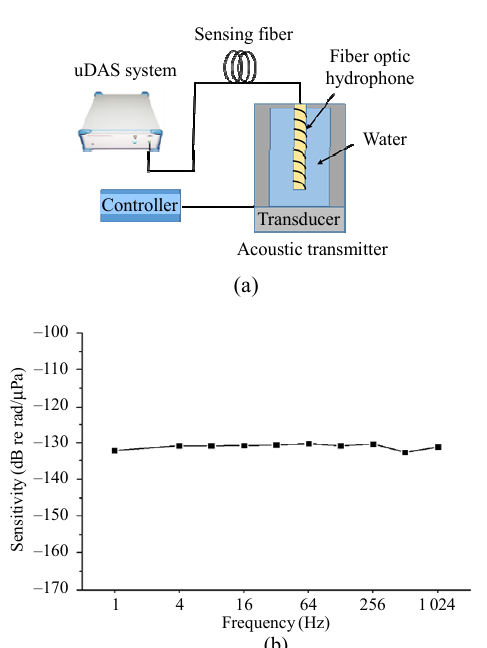
Fig. 29 (a) Schematic diagram of experimental setup for sensitivity test and (b) calibration curve of acoustic pressure sensitivity level.